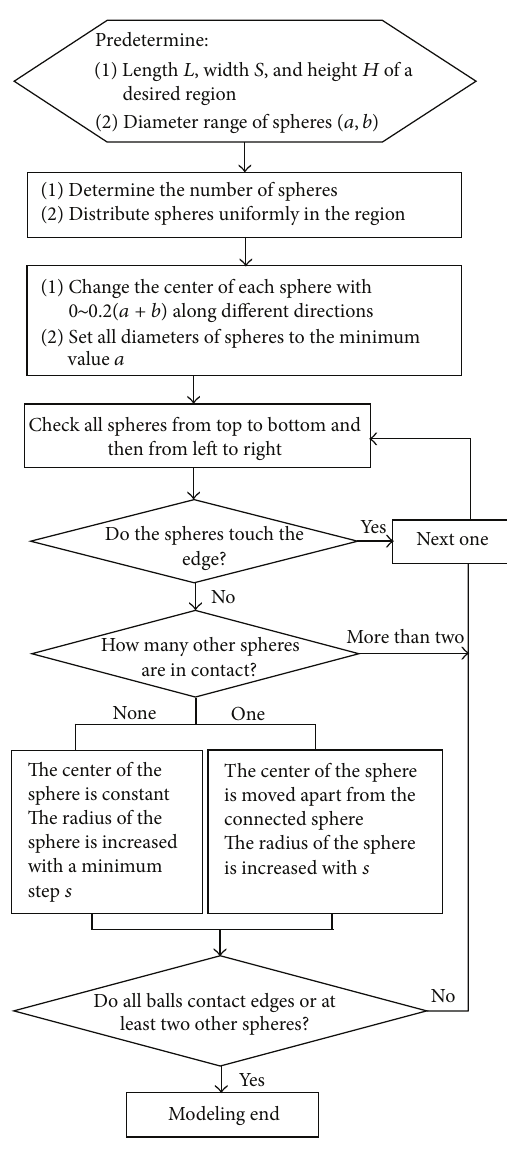
Figure 1: Modeling